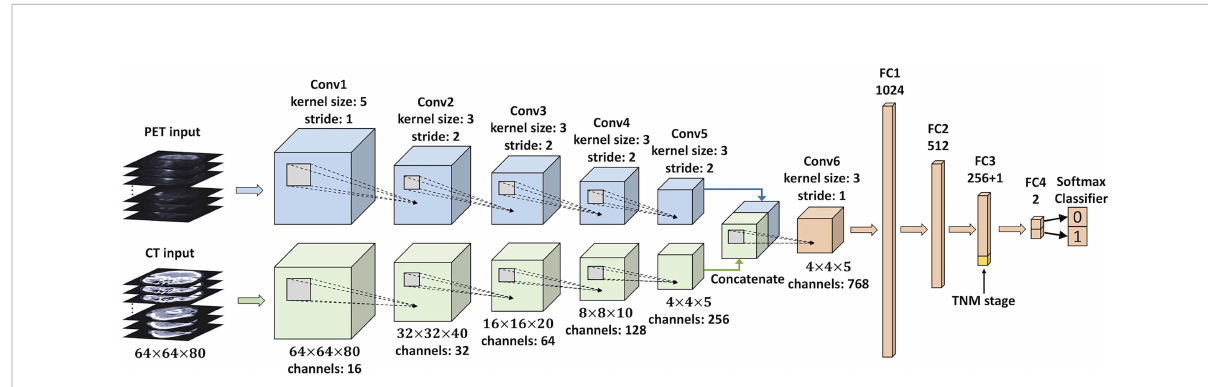
FIGURE 3 An illustration of the CNN used in the DLR analysis. This network takes a pair of preprocessed PET/CT patches (segmented ROIs) as input, and the fi nal layer (FC4) outputs normalized probabilities for both classes (0 or 1). The clinical feature (TNM stage) is concatenated with FC3. CNN, convolutional neural network; DLR, deep learning-based radiomics; ROIs, regions of